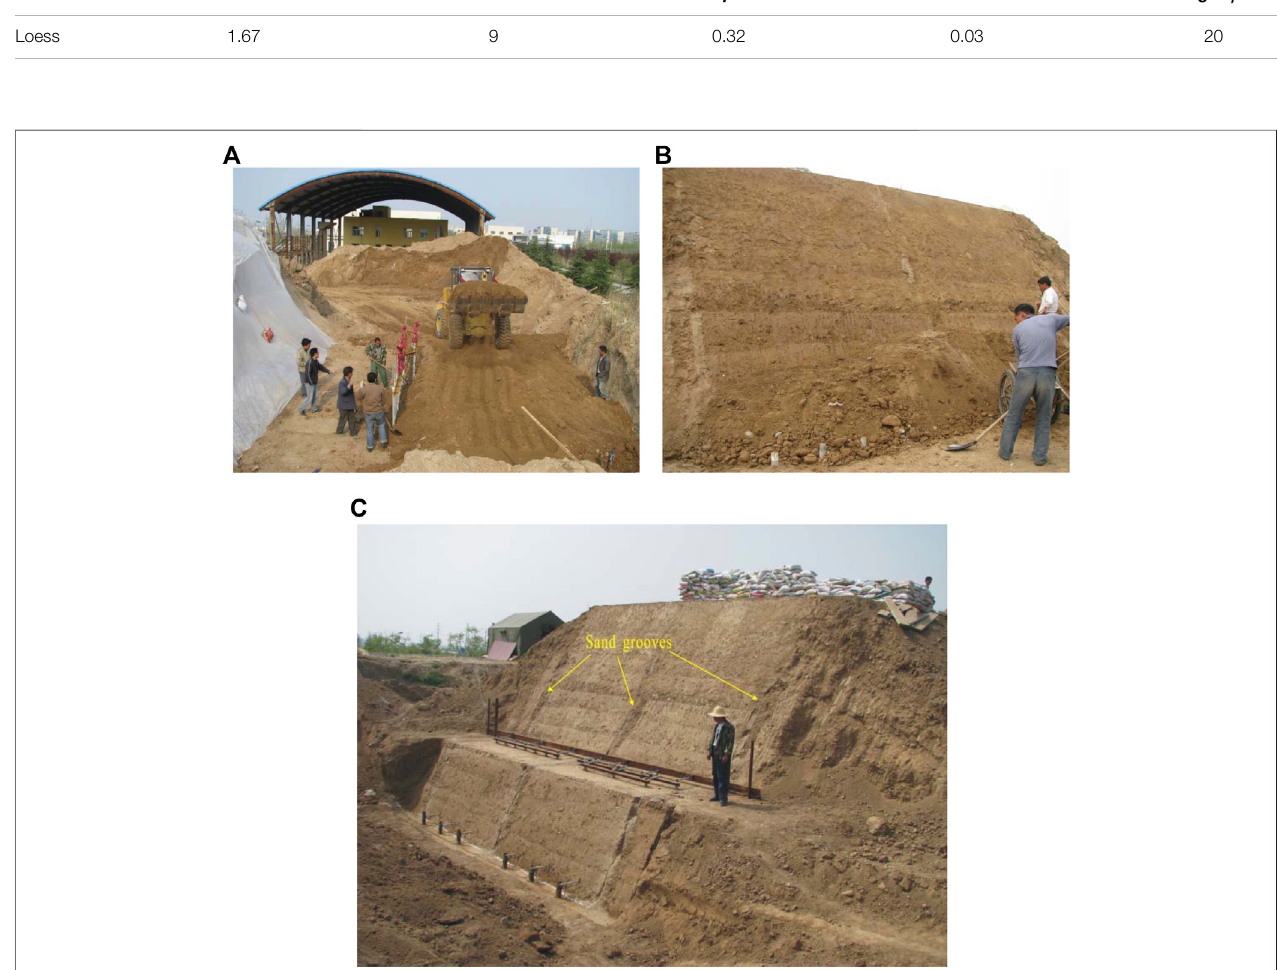
FIGURE 1 | Manufacturing process of the sliding body: (A) layered fi lling of soil, (B) removing excess soil, and (C) the completed test model.